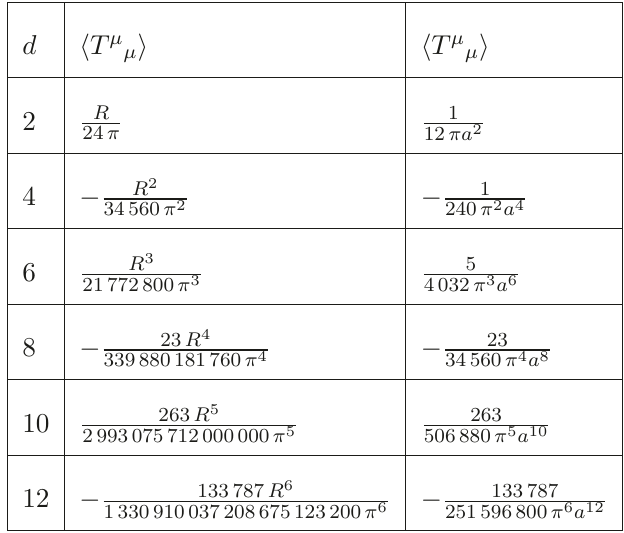
Table 1 . The type-A trace anomaly of a scalar